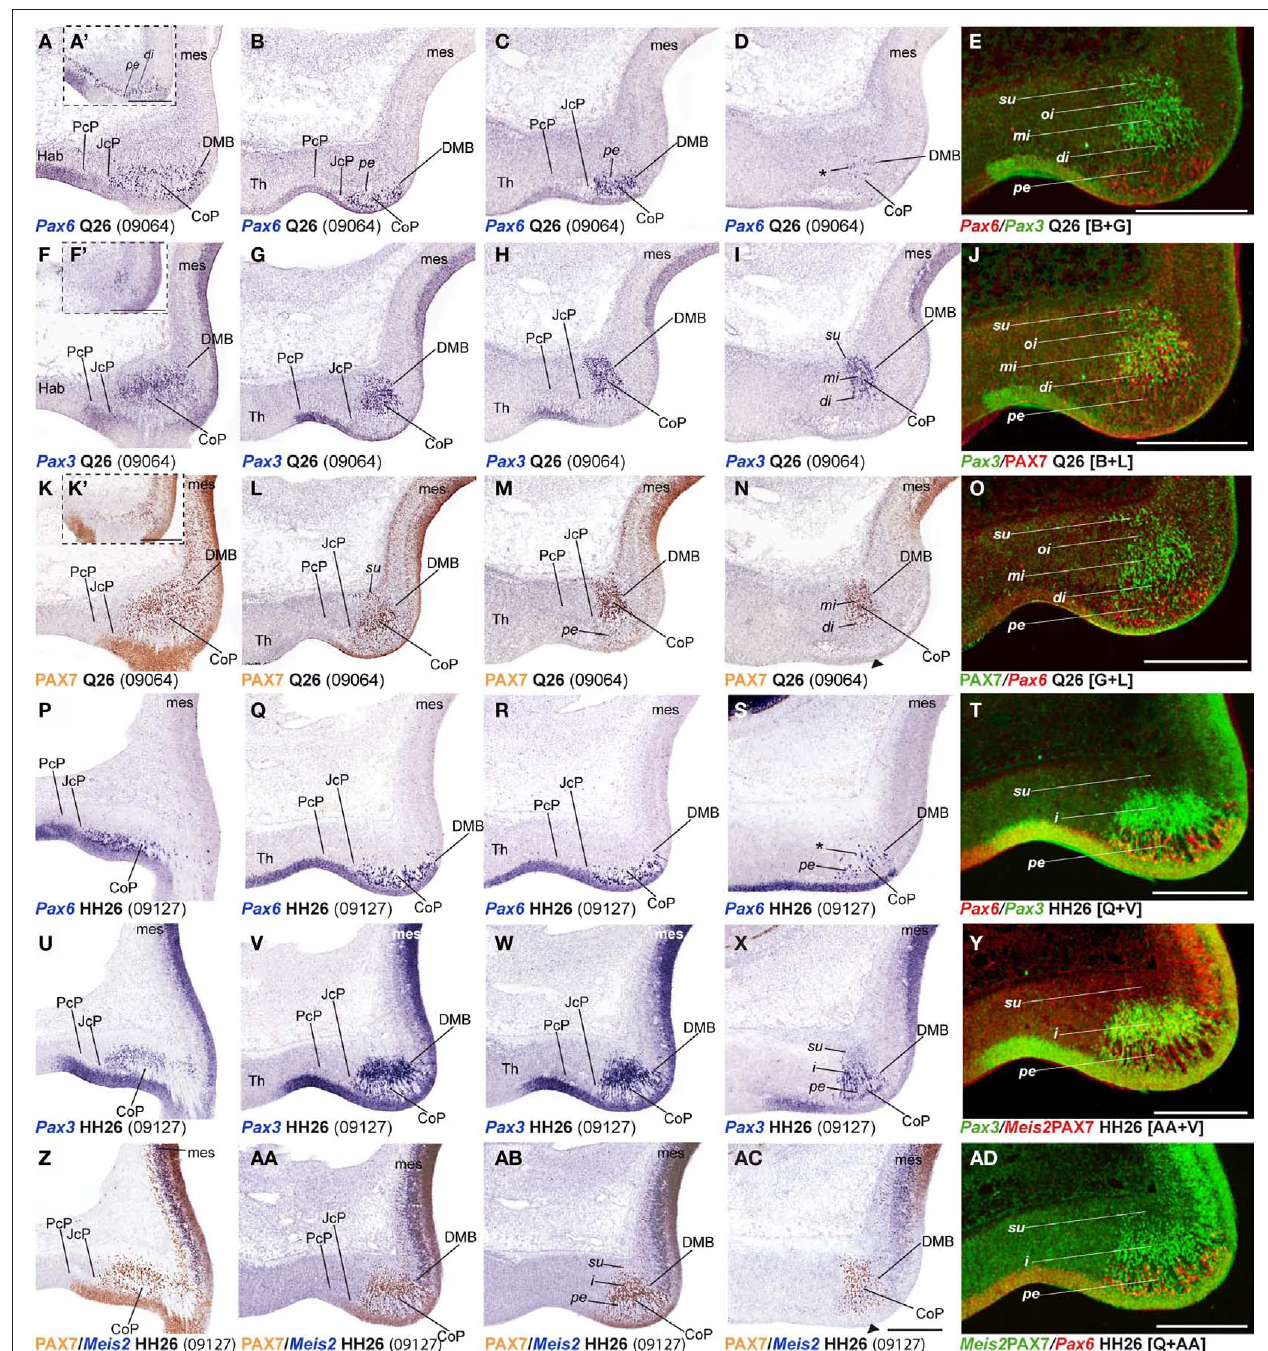
comparable material for the chick, so that panels taken long the vertical columns represent essentially the same section level and are comparable across the species. Insets (A ′ ,F ′ ,K ′ ) show a more dorsal section level, illustrating details of expression of the corresponding marker. Black arrowheads in (N,AC) indicate ventral levels of CoP ventricular zone lacking PAX7 immunoreaction. Asterisks in (D,S) identify Pax6 positive cells in the CoP deep intermediate layer. Numbers between brackets: code of the specimen in our collection. Scale bar in (AC) applies as well to (A–D,F–I,K–N,P–S,u–X,Z–AB) . Scale bars =